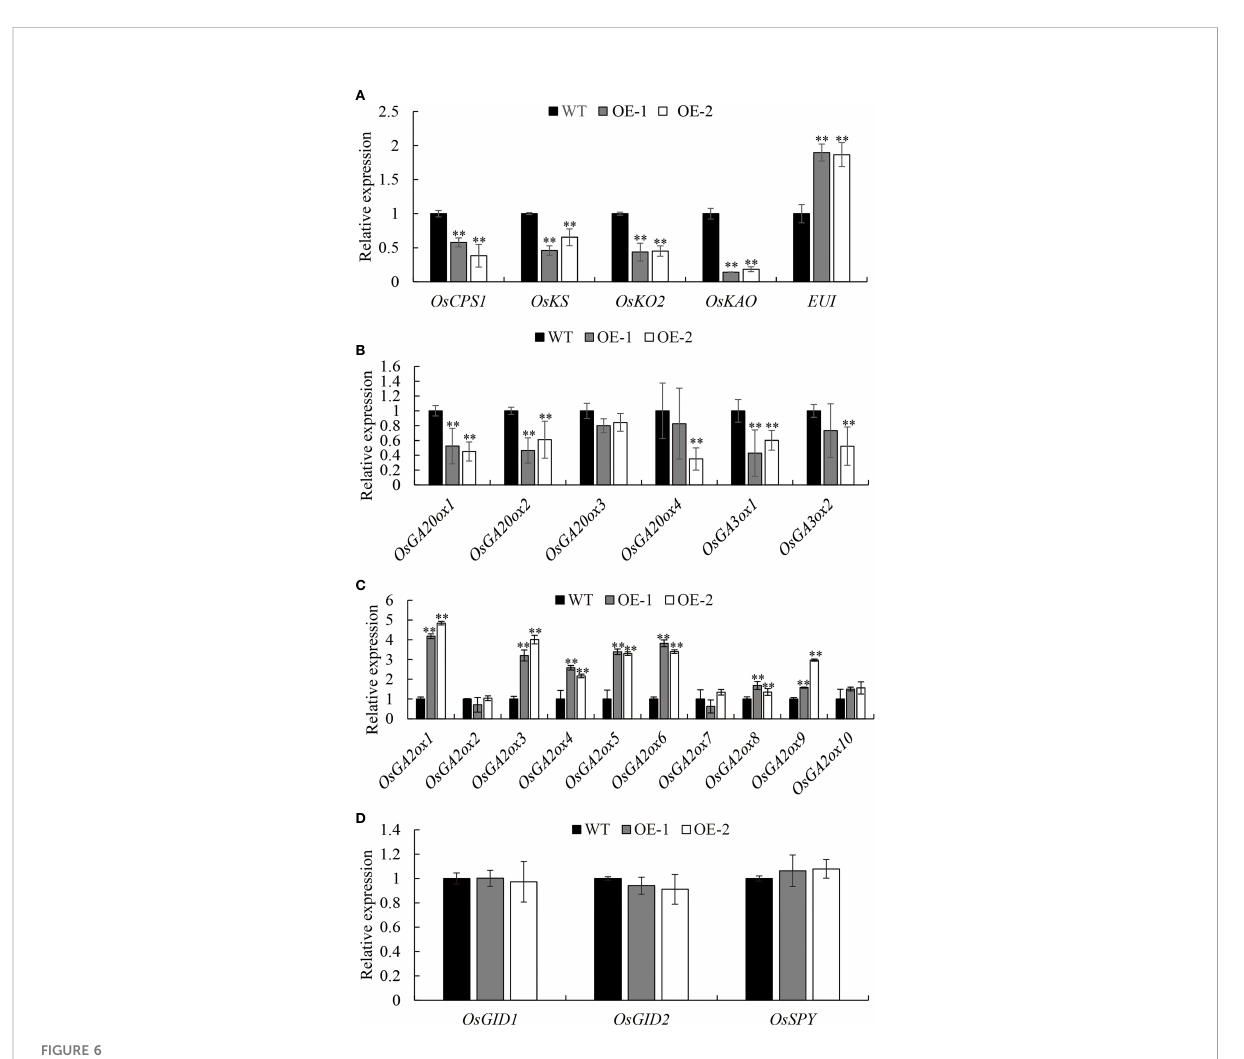
FIGURE 6 Expression analysis of GA metabolic (A – C) and signal genes (D) . Transcript levels from the WT were set to 1. Data are the mean ± SD (n = 3). Student ’ s t-tests were used to generate the P values. **Signi fi cant differences between the WT and OE lines at P =